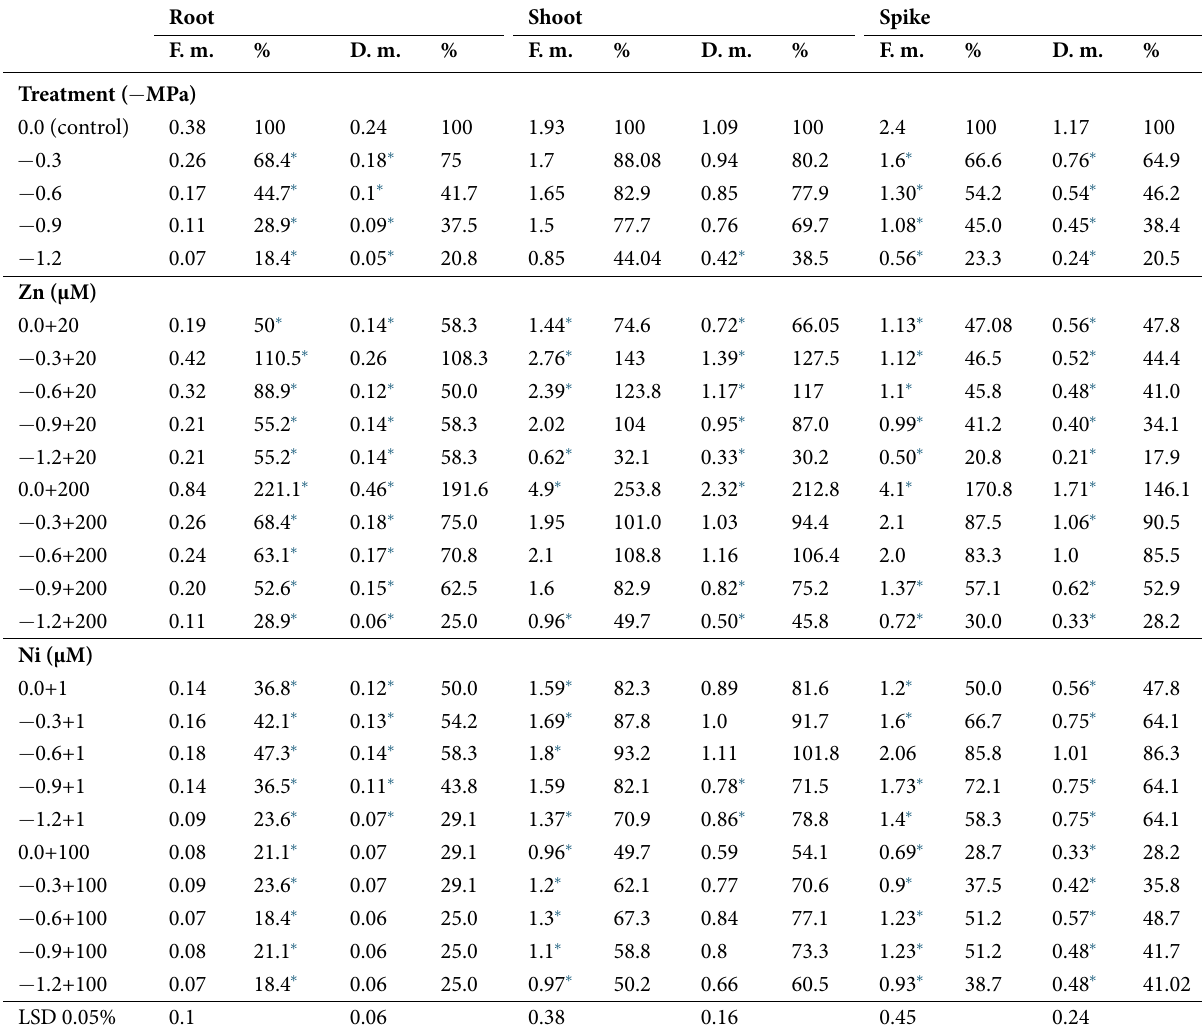
Table 1 Fresh and dry matter of roots, shoots and spikes (g/plant) of wheat as effected by different osmotic stress levels with or without Zn (20 and 200 μM) or Ni (1 and 100 μM)